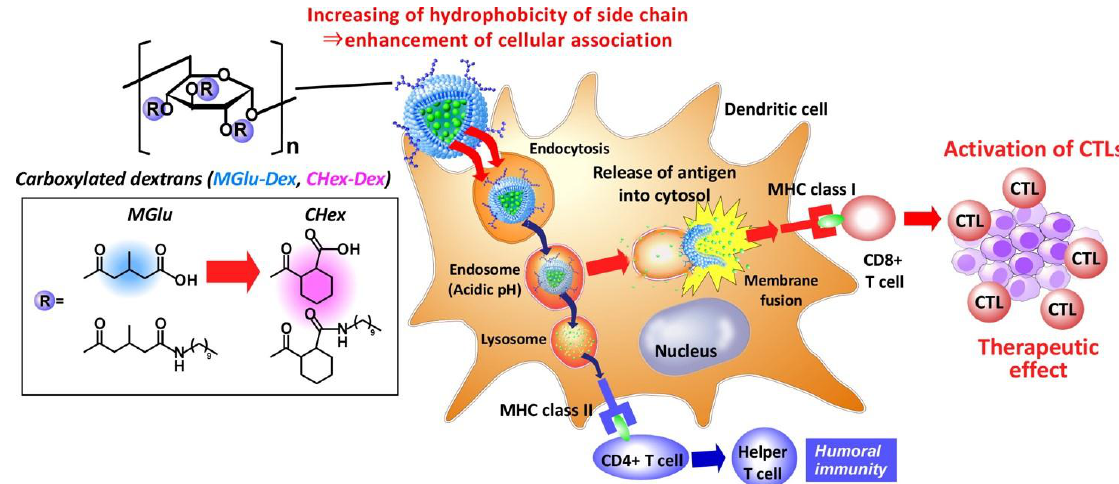
Figure 1. Carboxylated dextran derivative-modified liposomes for intracellular delivery of antigen to dendritic cells. CHex-Dex, which has more hydrophobic side chain than conventional MGlu-Dex, is expected to enhance cellular association and pH-responsive disruption of endosomal membrane of liposomes, leading to induction of cellular immunity.